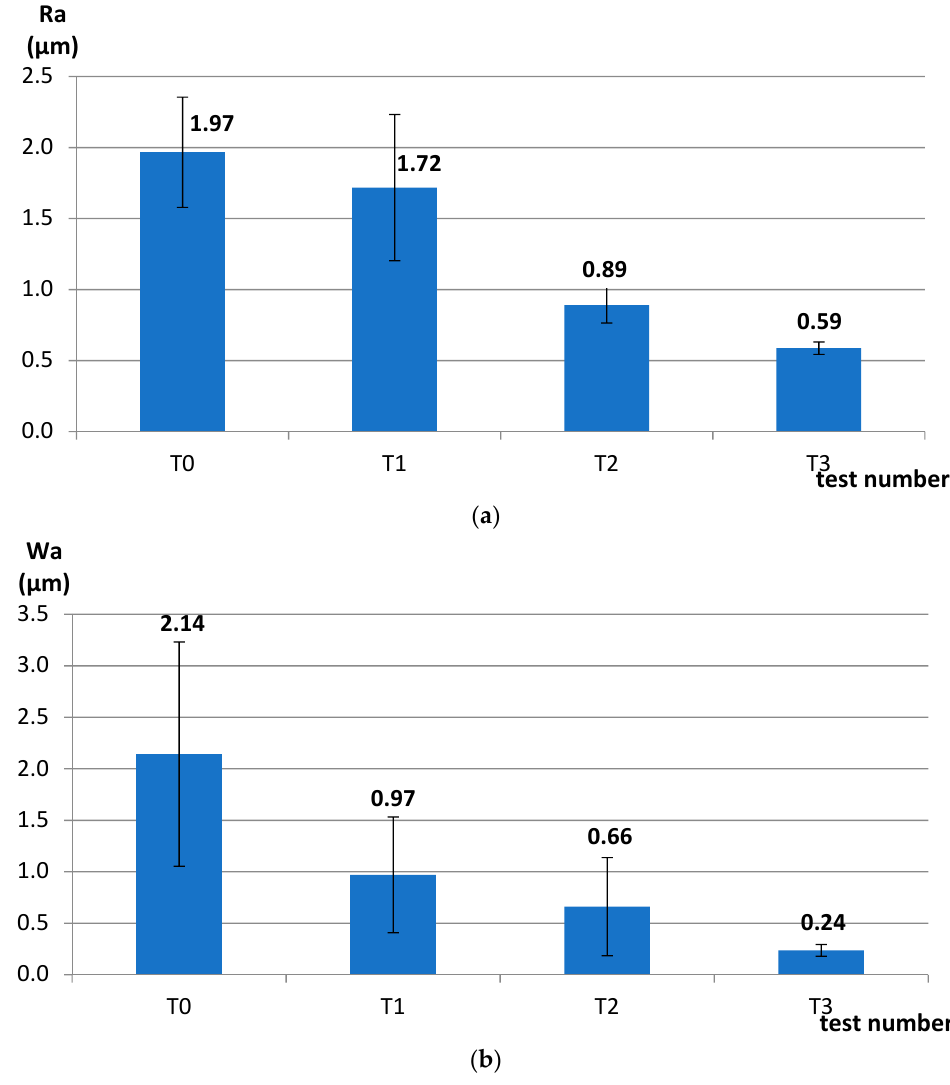
Figure 4. Average values of the roughness and waviness parameters after subsequent tests of single-sided lapping of Al 2 O 3 technical ceramics using a prototype tool made by the SLS method (T0—initial state of samples before processing): ( a ) Ra parameter, ( b ) Wa parameter; error bars show ± the standard deviation.